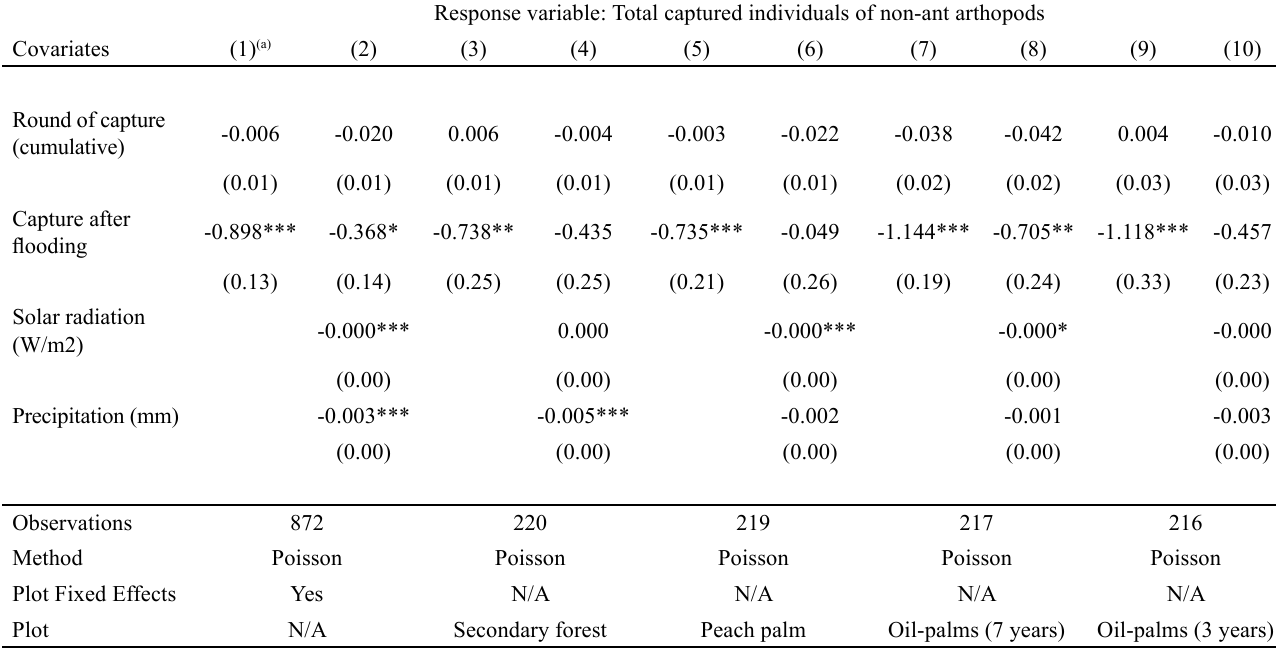
Table 5 . Estimated effect of pitfall trapping over non-ant arthropods by Negative Binomial (NB2) regression